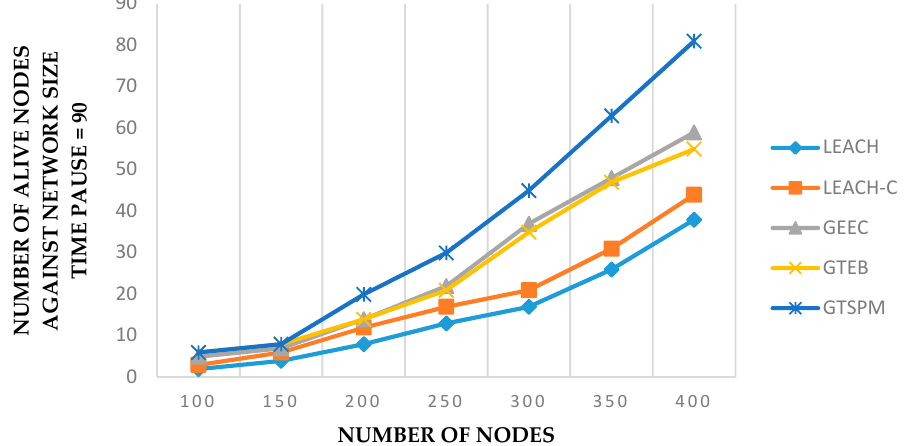
Figure 3. Number of alive nodes in different time pauses.